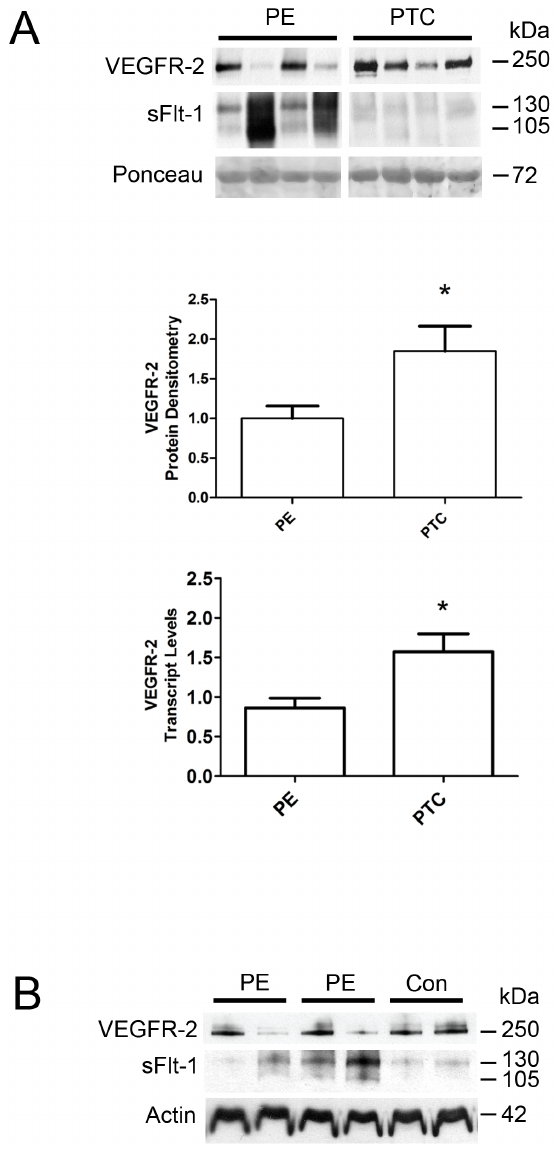
Figure 1. An inverse correlation between VEGFR-2 and sFlt-1 levels in preeclamptic placentae. A: Representative VEGFR-2 and sFlt-1 immunoblots of PE and PTC placentae. Densitometry analysis comparing normalized VEGFR-2 immunoreactivity between PE (n=13) and PTC (n=8) samples. VEGFR-2 transcript levels were assessed by qPCR analysis comparing PE (n=12) and PTC (n=7) samples. B: Representative VEGFR-2 and sFlt-1 immunoblots of placental tissues from PE and control (Con) dichorionic twins. (PE, preeclampsia; PTC, age-matched preterm control; * P , 0.05). All values are represented as the means 6 SEM.